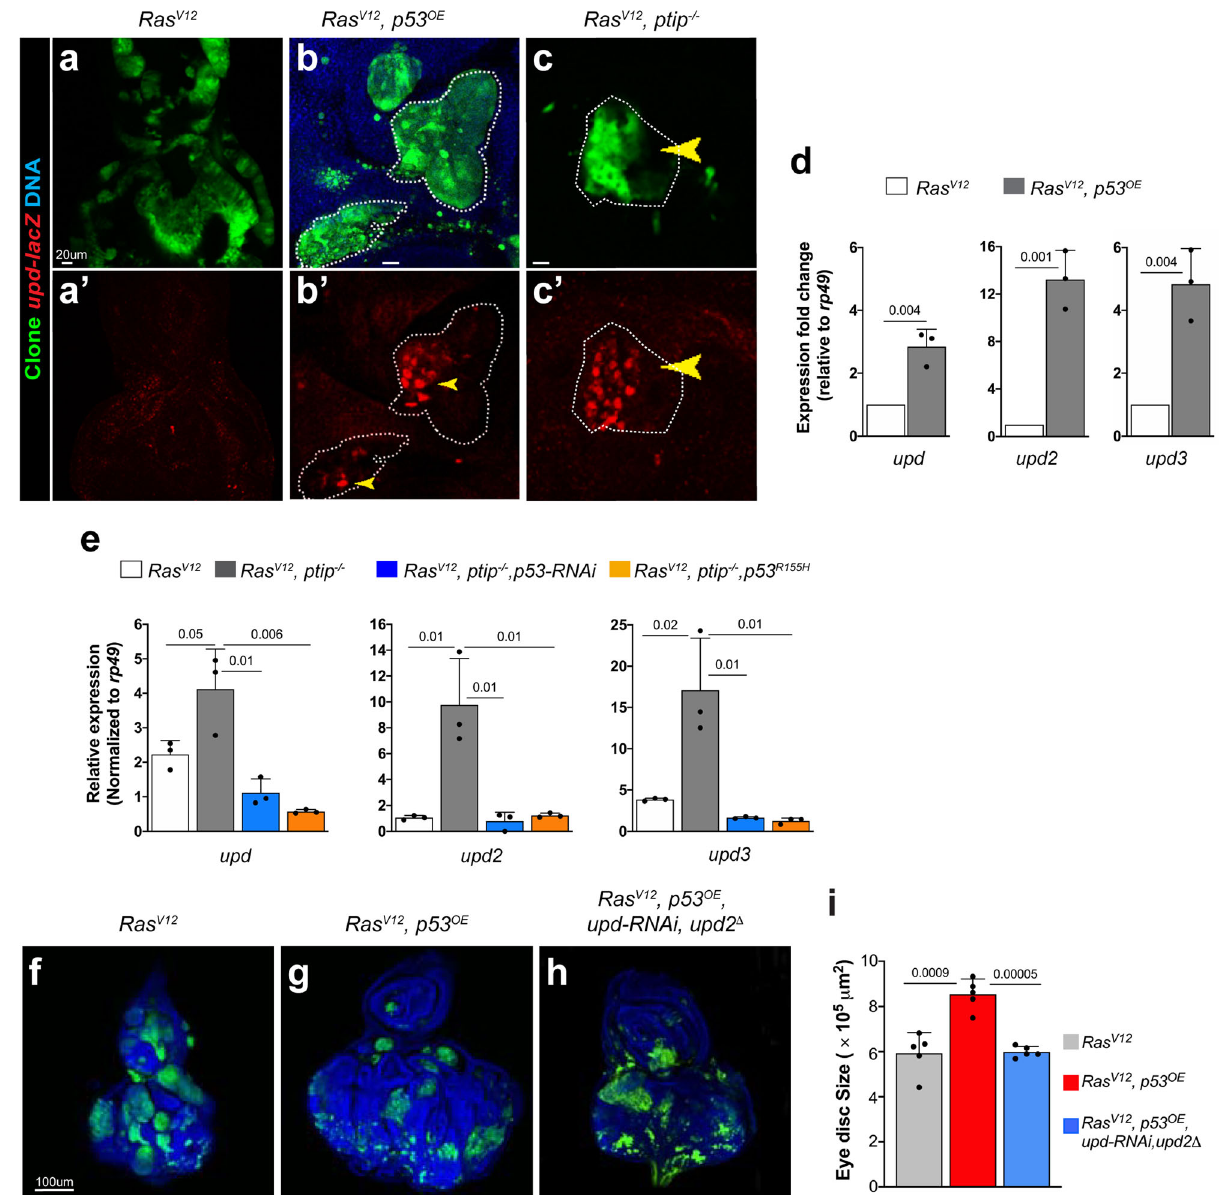
Fig. 3 Wild-type p53 and oncogenic Ras cooperatively stimulate STAT cytokines to drive nonautonomous tissue overgrowth. ( a – c ′ ) Images showing upd-lacZ expression in eye imaginal discs bearing Ras V12 ( a, a ′ ) , Ras V12 p53 OE ( b, b ′ ), and Ras V12 ptip − / − ( c, c ′ ) clones. Anti- β gal antibodies were used in immunostaining experiments to detect LacZ. The individual LacZ channel images are shown in a ′ – c ′ . The dotted white lines denote clone boundaries and depict representative examples of upd overexpression (yellow arrowheads). Scale bars are 20 µ m. ( d , e ) qPCR data showing expression of upd , upd2 , and upd3 in Ras V12 versus Ras V12 p53 OE ( d ) or Ras V12 ptip − / − in the absence or presence of p53 inhibition ( Ras V12 ptip − / − p53 RNAi or Ras V12 ptip − / − p53R 155H ). Expression was normalized to the transcript abundance of rp49 , a housekeeping gene. Error bars denote SD values. P values are derived from Student ’ s t test analyses. ( f – h ) Representative images showing overall tissue size of dissected eye imaginal discs harboring GFP-labeled Ras V12 ( f ) or Ras V12 p53 OE ( g ) or Ras V12 p53 OE upd RNAi upd2 Δ ( h ) clones. Blue signal represents DNA (DAPI stain). Scale bar is 100 µ m. ( i ) Quanti fi cation of tissue sizes from ( f – h ). Sample size N = 06 tissues per genotype. Error bars denote SEM values. P values are derived from Student ’ s t test analyses. Effect size ( d ) values for ( f – h ) are greater than